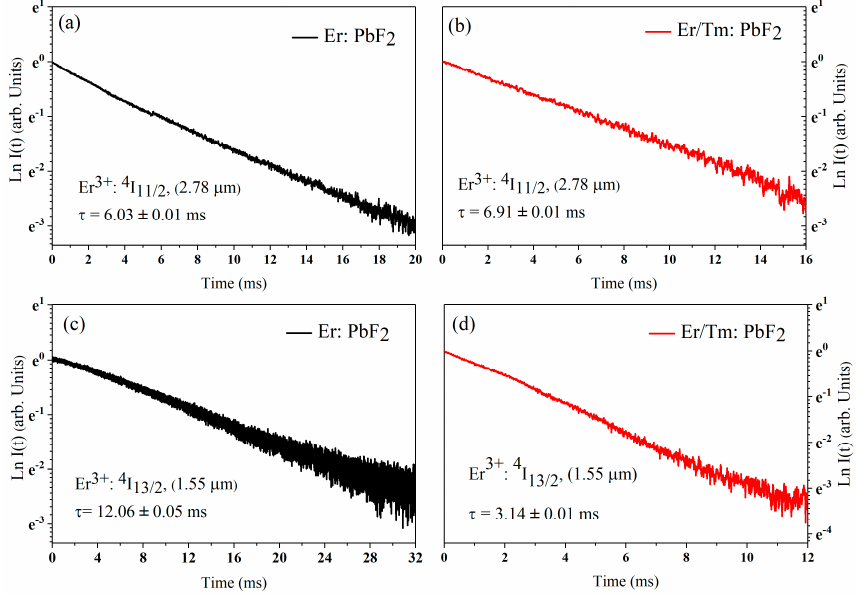
Figure 9. ( a ) Fluorescence decay curves of the Er 3+ : 4 I 11/2 energy level of Er: PbF 2 crystal ( λ ex = 800 nm, λ em = 2780 nm); ( b ) Er 3+ : 4 I 11/2 energy level of Er/Tm: PbF 2 crystal ( λ ex = 800 nm, λ em = 2780 nm); ( c ) Er 3+ : 4 I 13/2 energy level of Er: PbF 2 crystal ( λ ex = 1490 nm, λ em =1550 nm); ( d ) Er 3+ : 4 I 13/2 energy level of Er/Tm: PbF 2 crystal ( λ ex = 1490 nm, λ em = 1550 nm). Table 1. MIR emission cross-sections σ em , and lifetimes of 4 I 11/2 , 4 I 13/ 2 levels of Er/Tm: PbF 2 , Er: PbF 2 crystals compared with other Er 3+ -doped crystals.